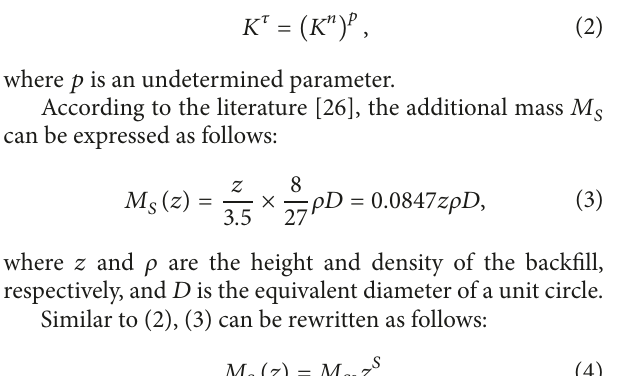
Figure 1: Simplified mechanical model of a retaining wall-soil system.